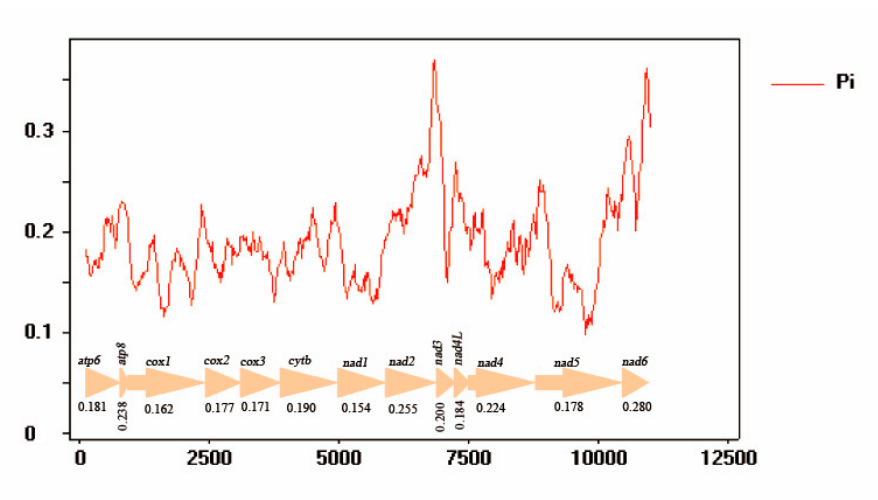
Figure 6. Structures of AT-rich region in mitogenomes of Epuraea sp. and X. variegatus . The dark red ellipses are the tandem repeat regions, the blue blocks indicate non-repeat regions, the green circles are the poly-T stretches, and the purple circles are poly-C stretches.